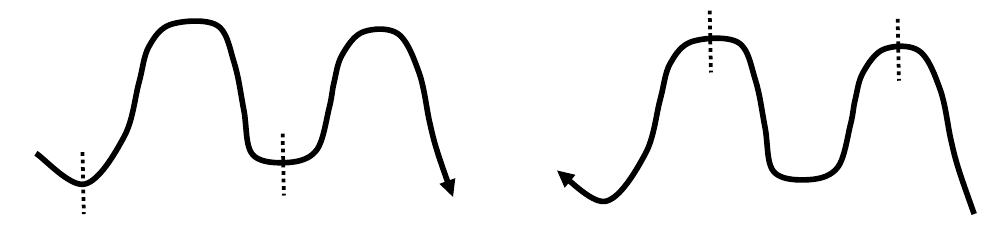
Figure 1. Minima of curvature (indicated by slashes) (Arrows indicate curve orientation).